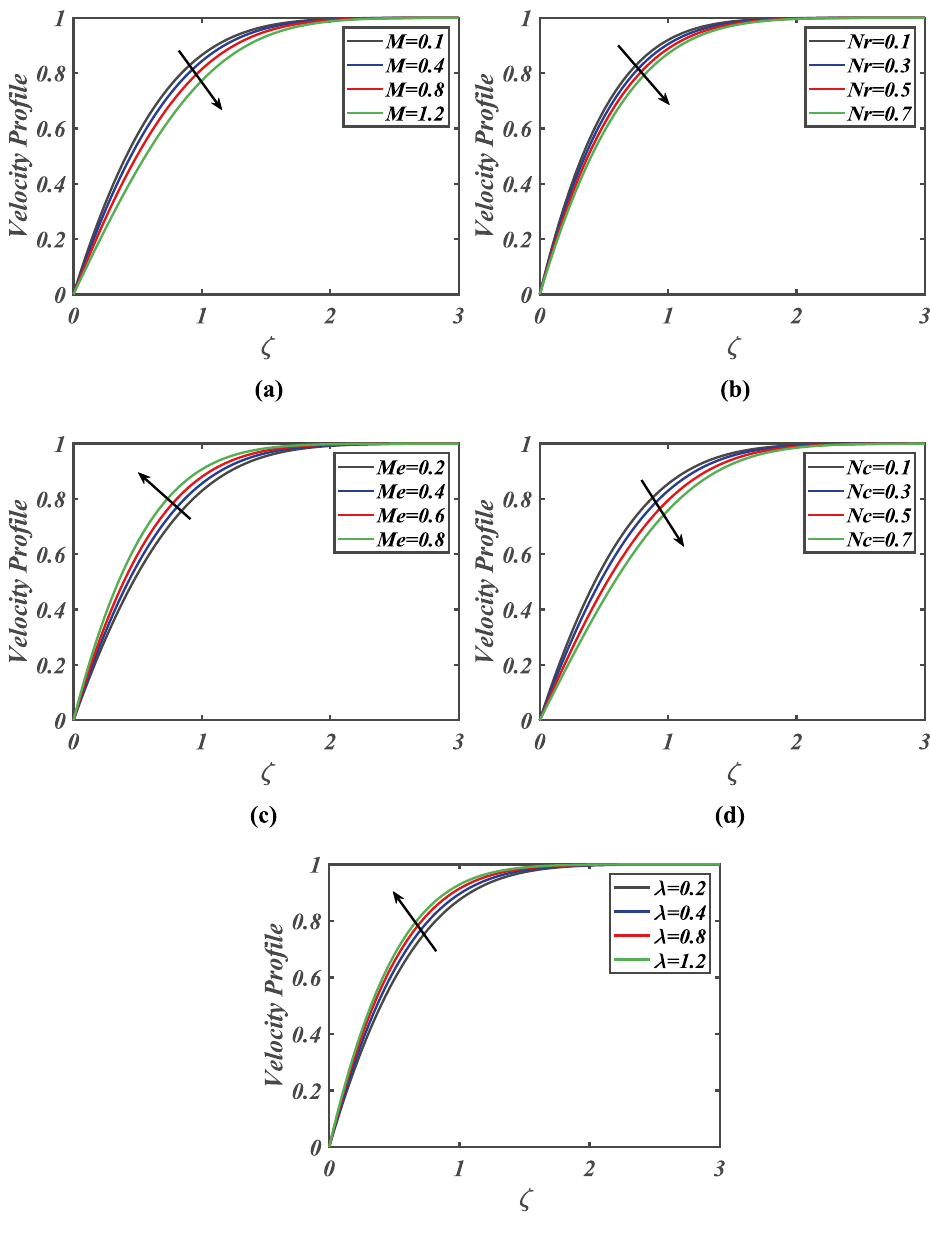
Figure 2. (a)–(e) Response of velocity f ′ against varied values of M , Nr , Me , Nc and (cid:31)